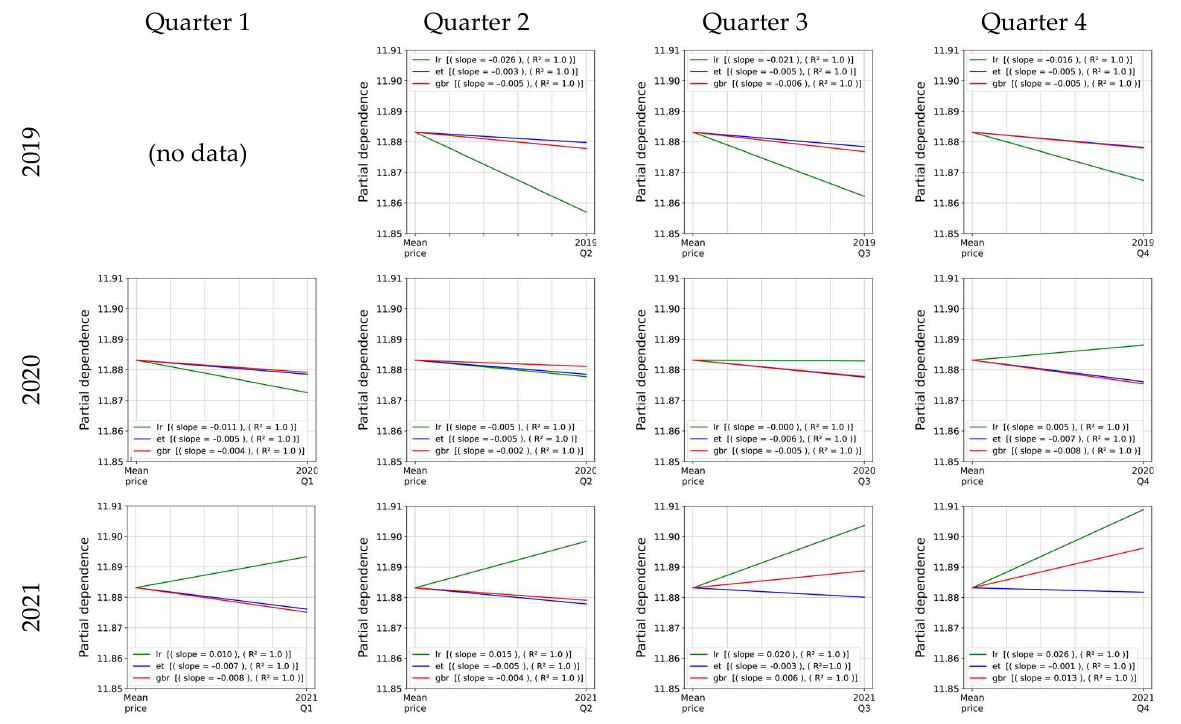
Figure 19. One-way partial dependence plots for temporal features with lr , et , and gbr